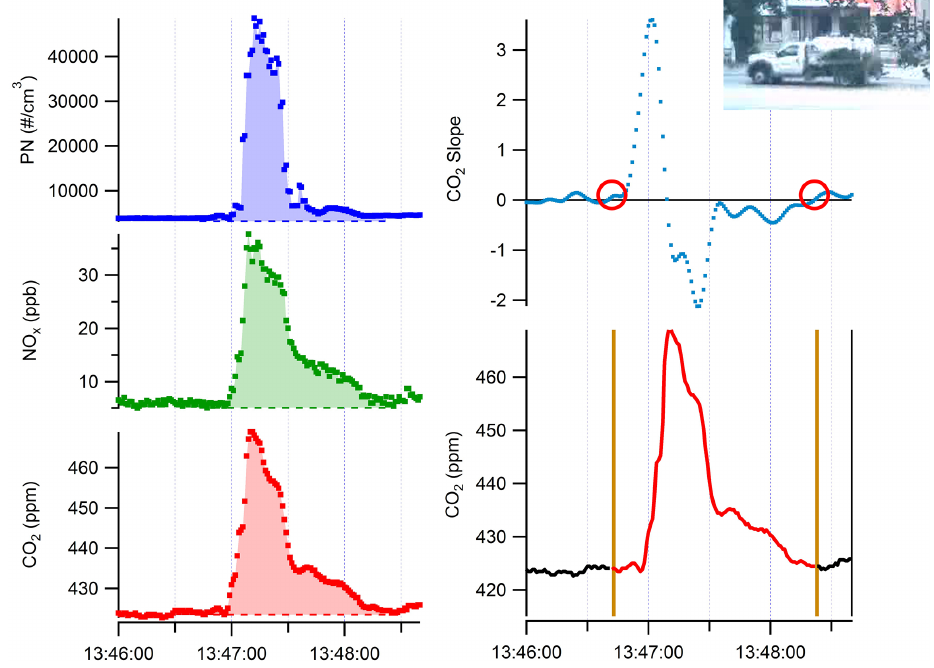
Figure 2. Time series of CO 2 , NO x , and particle number concentration from a vehicle plume (left). The slope of CO 2 and the automated identification of the plume (right) with vertical lines marking the beginning and end of the plume period. Video footage (top right) of a utility truck was associated with the identified